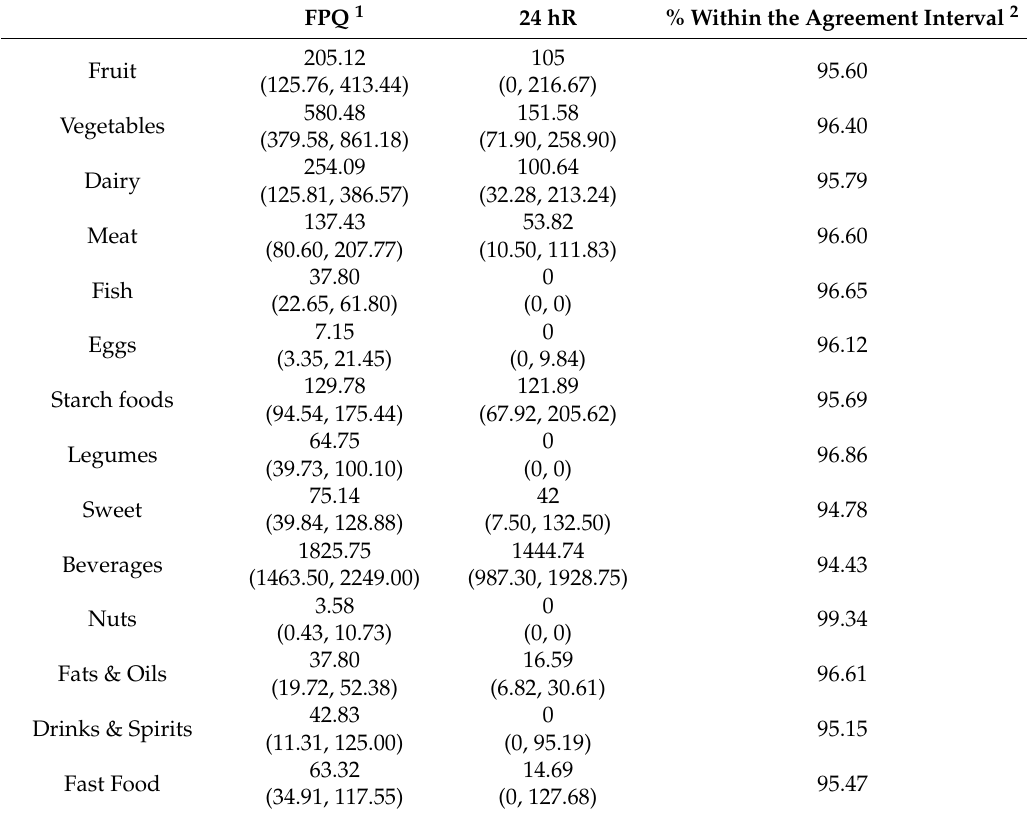
Table 5. Distribution of Consumption of the Foods and Beverages in the Validation Study and Results from the Bland–Atman Analysis of Validity